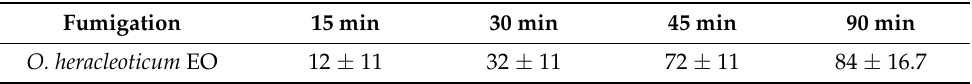
Table 3. Mean and SD ( ± ) percent of V. destructor mites that were examined and found dead at 48 h, after each interval of exposure to oregano O. heracleoticum essential oil (EO) vapors. Fumigation